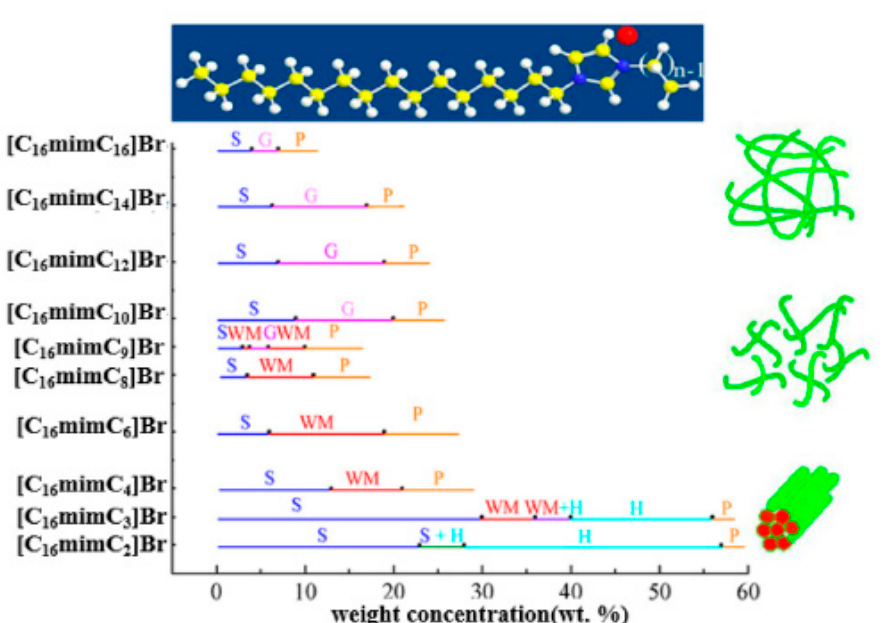
Figure 1. Formation of different morphologies as a function of the surfactant molecular structure (1-C 16 -3-R-imidazolium bromides; R = C 2 to C 16 ) and their concentration in water. S, H, WM, G and P refer to isotropic solution, hexagonal liquid crystals, wormlike micelles, hydrogel and ionic liquid-based surfactants precipitation, respectively [2]. Reprinted with permission from ref. [2]. Copright 2021 Elsevier.